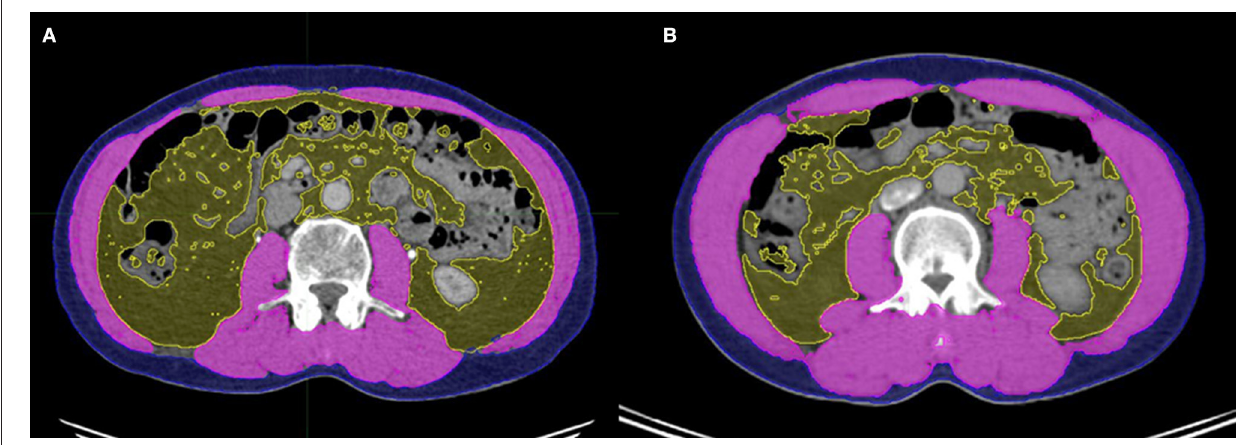
FIGURE 1 | Slices of computed tomography (CT) images of patients with (A) and without (B) sarcopenia who had similar body mass indices. Skeletal muscle, visceral adipose tissue, and subcutaneous adipose tissue were measured using the MIM Vista software (MIM corp., version 6.1, OH, USA).